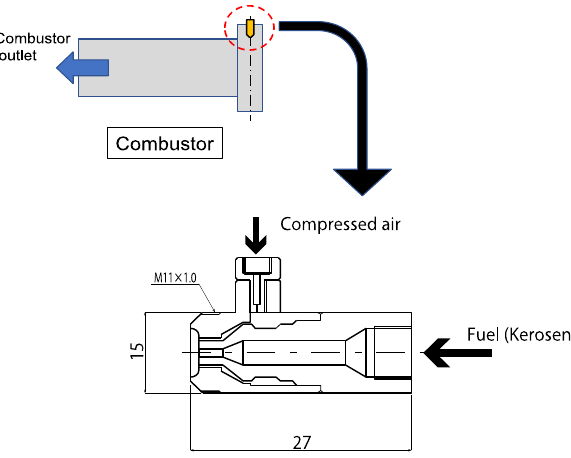
Figure 3. Fuel nozzle (fuel nozzle using compressed air).